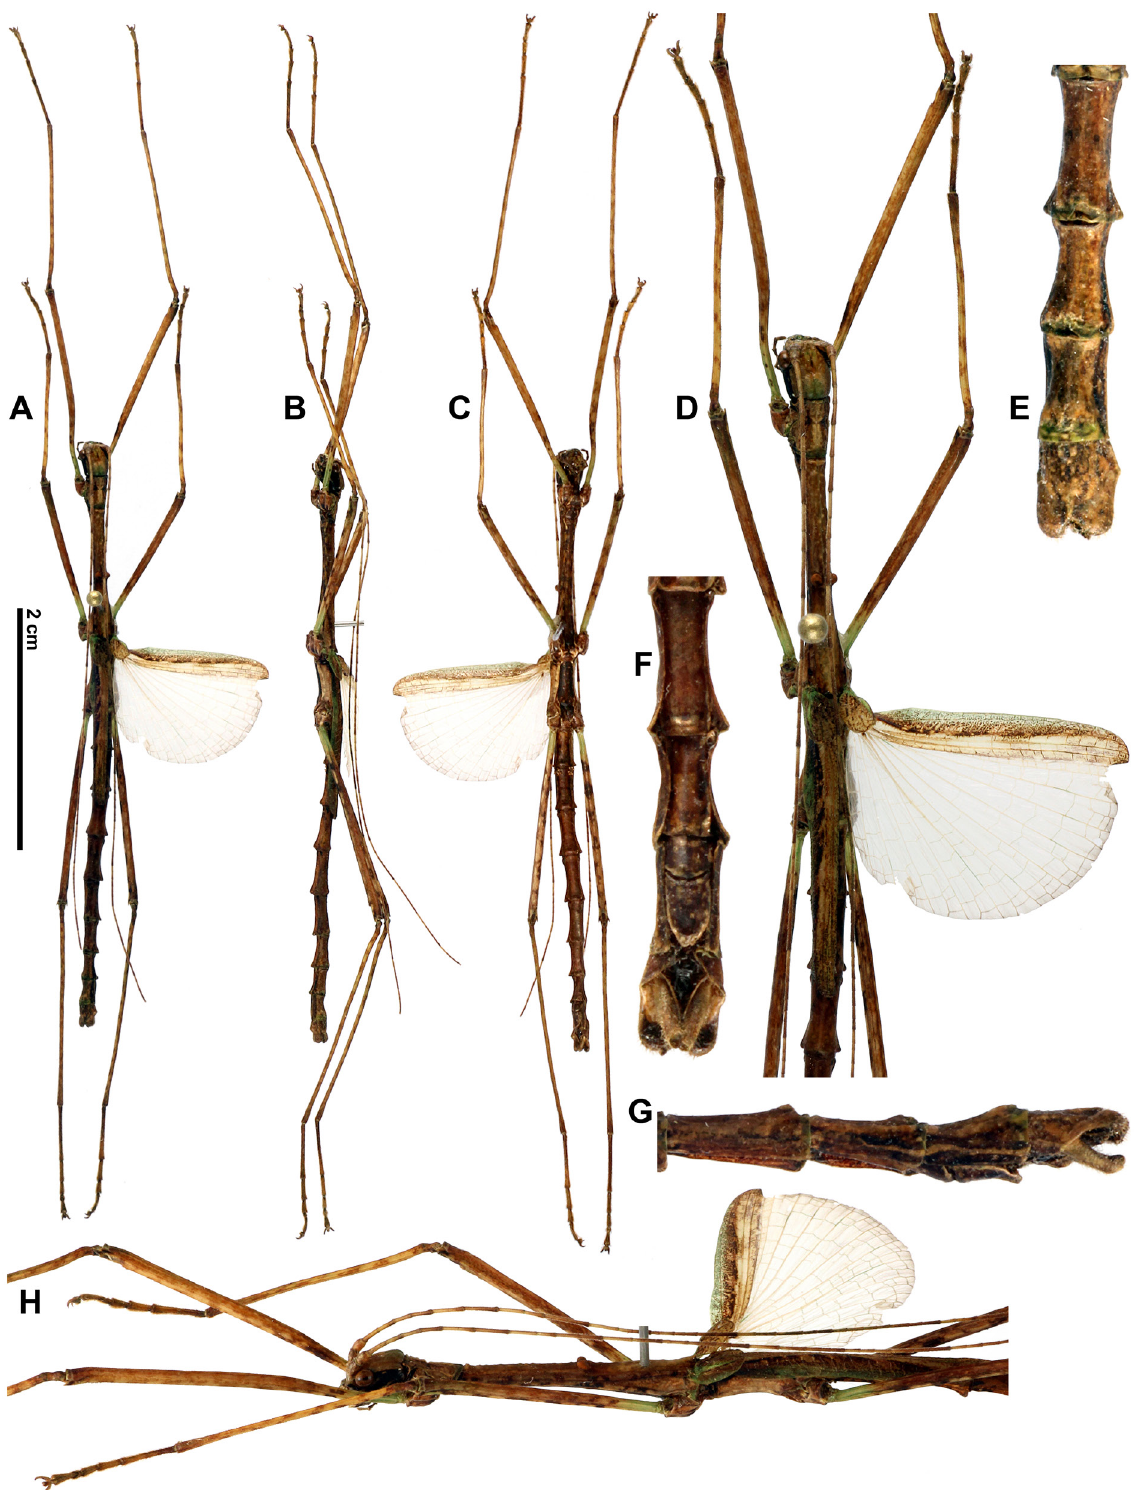
Fig. 8. Otraleus christianae sp. nov., ♂, holotype. A . Habitus, dorsal view. B . Habitus, lateral view. C . Habitus, ventral view. D . Anterior part of body, dorsal view. E . Apex of abdomen, dorsal view. F . Apex of abdomen, ventral view. G . Apex of abdomen, lateral view. H . Anterior part of body, lateral view. D–H: not to